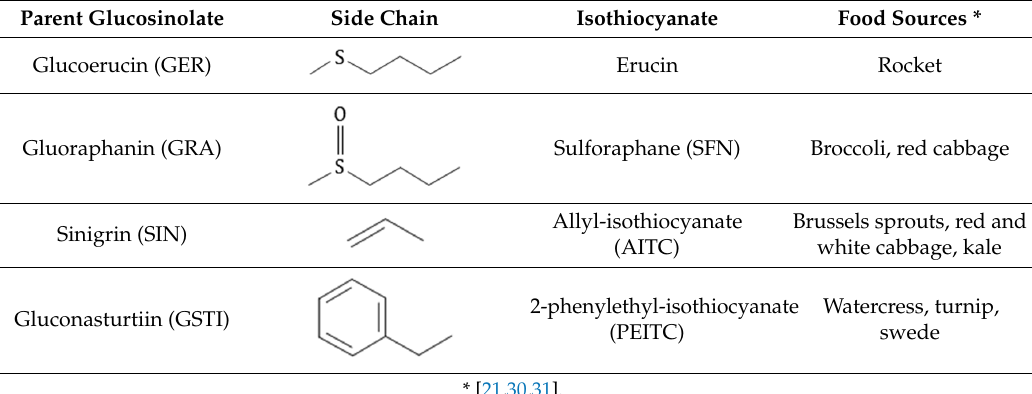
Table 1. Food sources of the GLS test compounds and chemical structures of the GLS side chains.